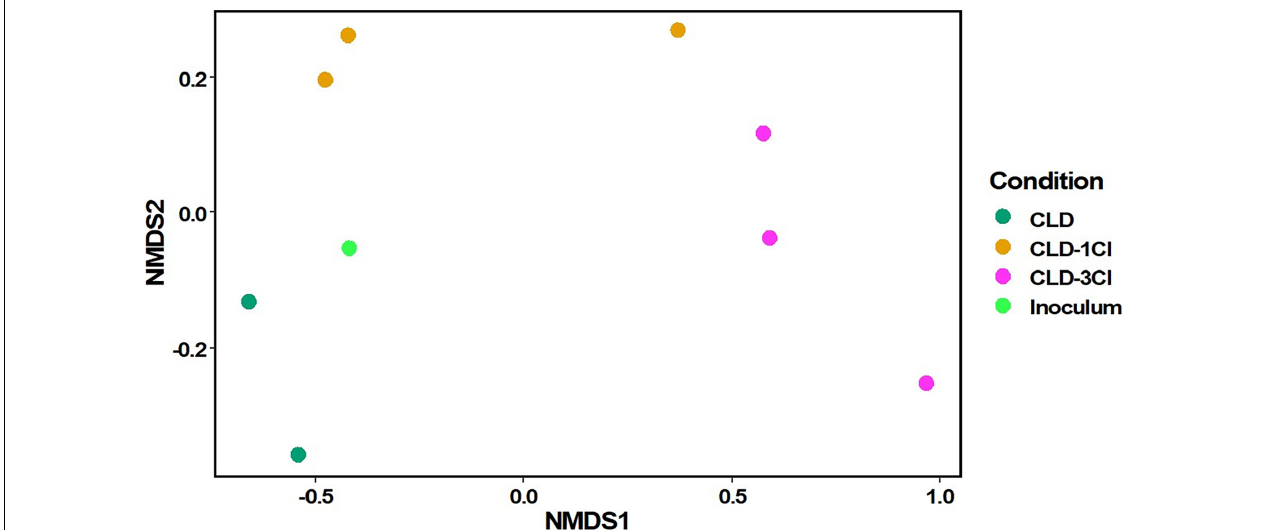
identify both the transformation products and the dominant genera